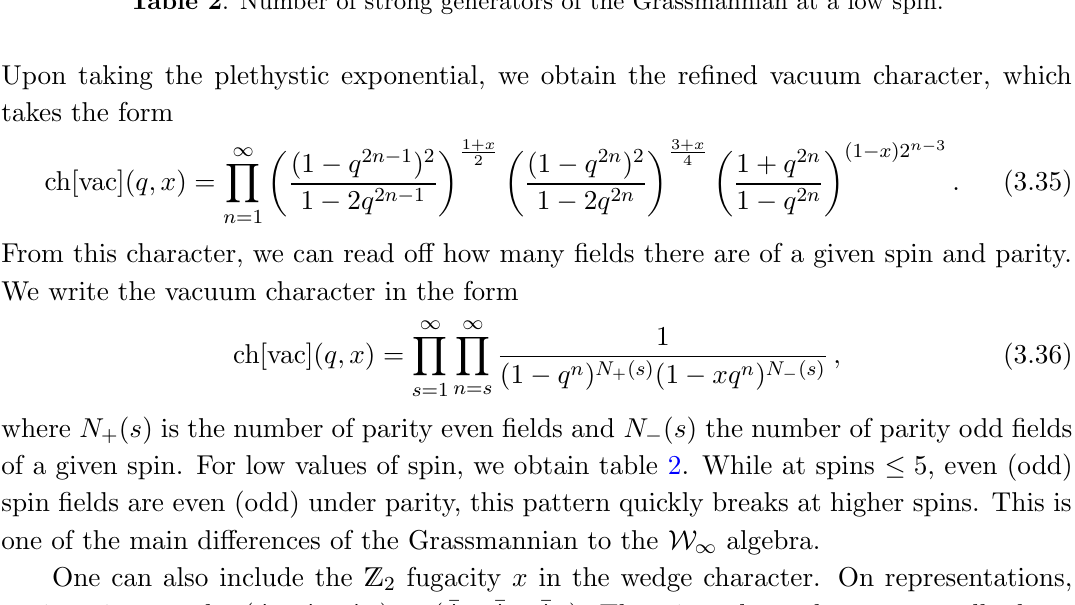
Table 2 . Number of strong generators of the Grassmannian at a low